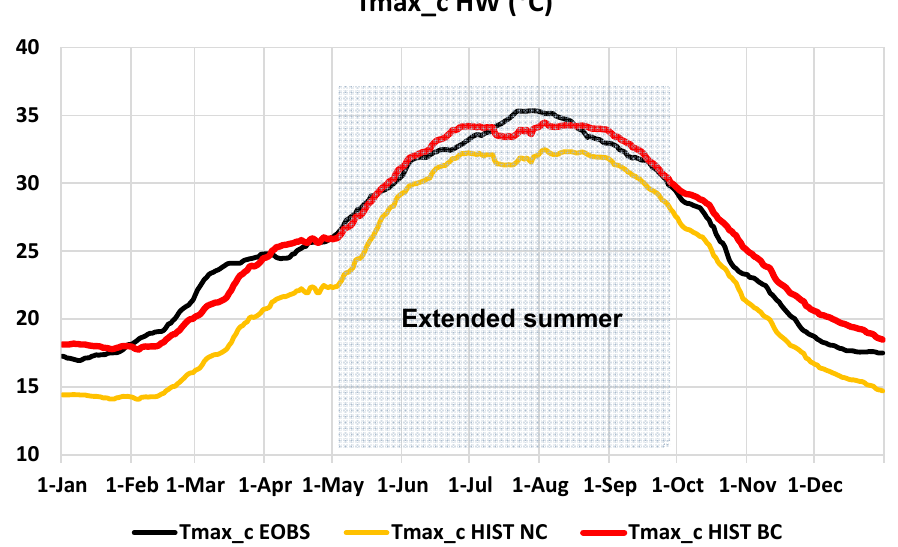
Figure 5. Tmax_c (i.e., threshold) for each calendar day for EOBS and WRF NC and